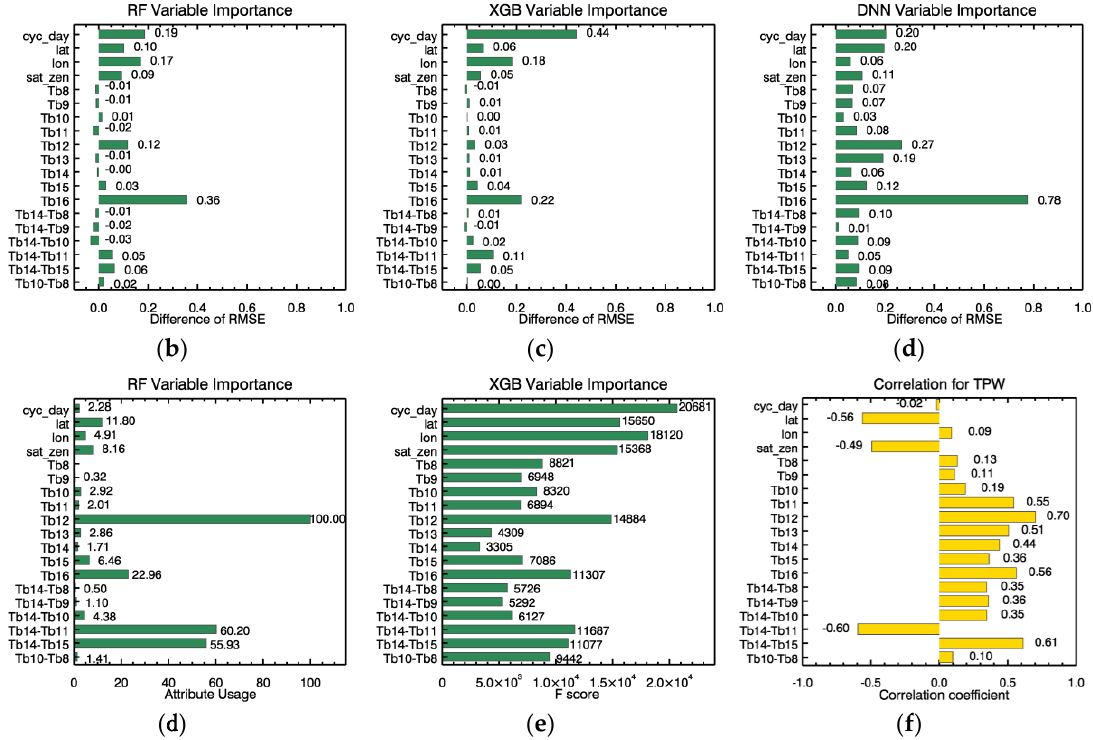
Figure 6. Relative variable importance identified by ( a ) RF, ( b ) XGB, and ( c ) DNN. Bar plots using input variables of the training dataset: the x-axis is the difference of root mean square error (RMSE) and the y-axis is the corresponding name of input variables. The difference in RMSE (the original RMSE − new RMSE) is calculated using the leave-one-variable-out method. The original RMSE of RF, XGB, and DNN are 2.63, 2.46, 2.69 mm, respectively. The variable importance is calculated after the construction of ensemble trees for the rule-based models ( d ) RF and ( e ) XGB. The longer the length of the bar is, the more important the variable is. ( f ) summarizes correlation coefficients between the input variables and TPW.